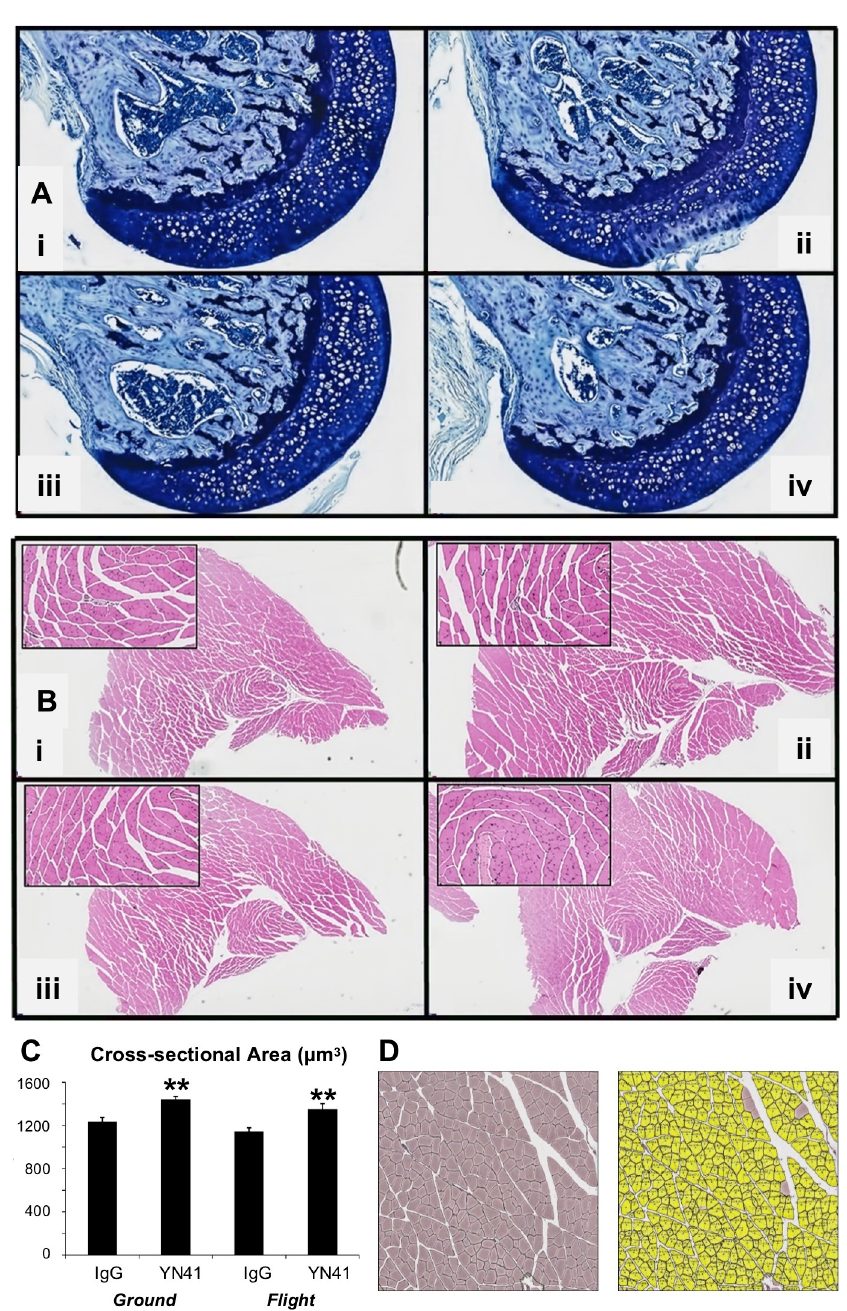
Fig 3. Effect of myostatin inhibition and microgravity on femoral head and muscle histology and myofiber size. A). No degenerative or inflammatory changes were microscopically observed in observed in longitudinal sections of the femoral head near the ligament of the head of the femur (A) or in transverse sections of the lower hind limb muscles (B) in control or YN41 treated mice housed on the ground or in flight. i) Ground IgG, ii) Ground YN41, iii) Flight IgG, iv) Flight YN41. High magnification inset in B is of the soleus muscle (centrally located). (C). Mean cross- sectional areas of lower limb hindlimb muscle fibers from ground and flight groups, where two-way ANOVA showed main effects of both myostatin inhibition (p < 0.0001) and spaceflight (p < 0.05). �� p < 0.001 vs their respective IgG controls. D). Representative image of a lower limb muscle section (top) stained to highlight muscle fibers and its corresponding image analysis mask (bottom) used as part of the image analysis